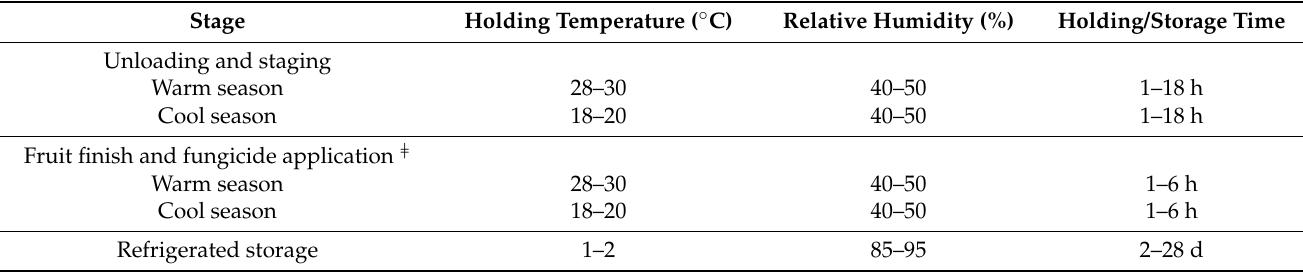
Table 1. Stone-fruit handling, processing and storage conditions at a commercial